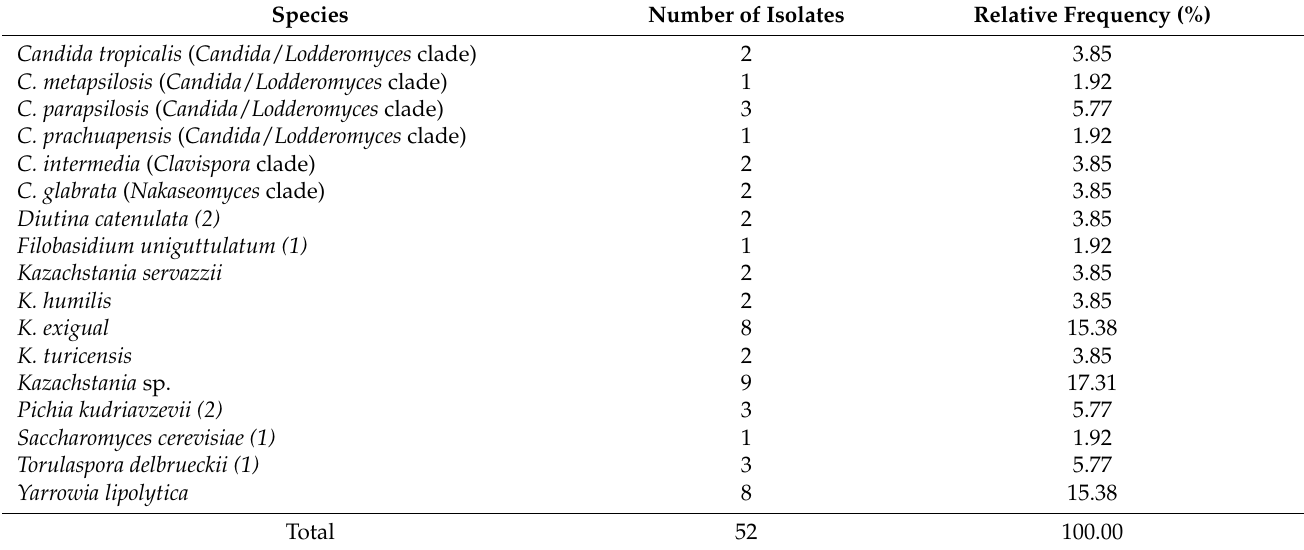
Figure 4. Proportion of yeast genera discovered in Plaa-som samples collected from fresh markets in Thailand. Table 3. Yest species found in Plaa-som samples collected from fresh markets in